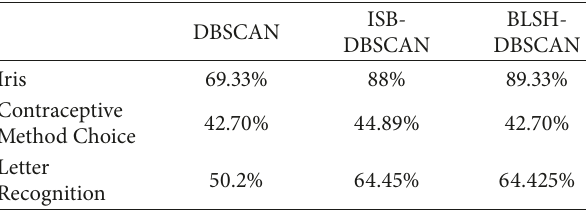
Table 4: Correct rate comparison in different UCI